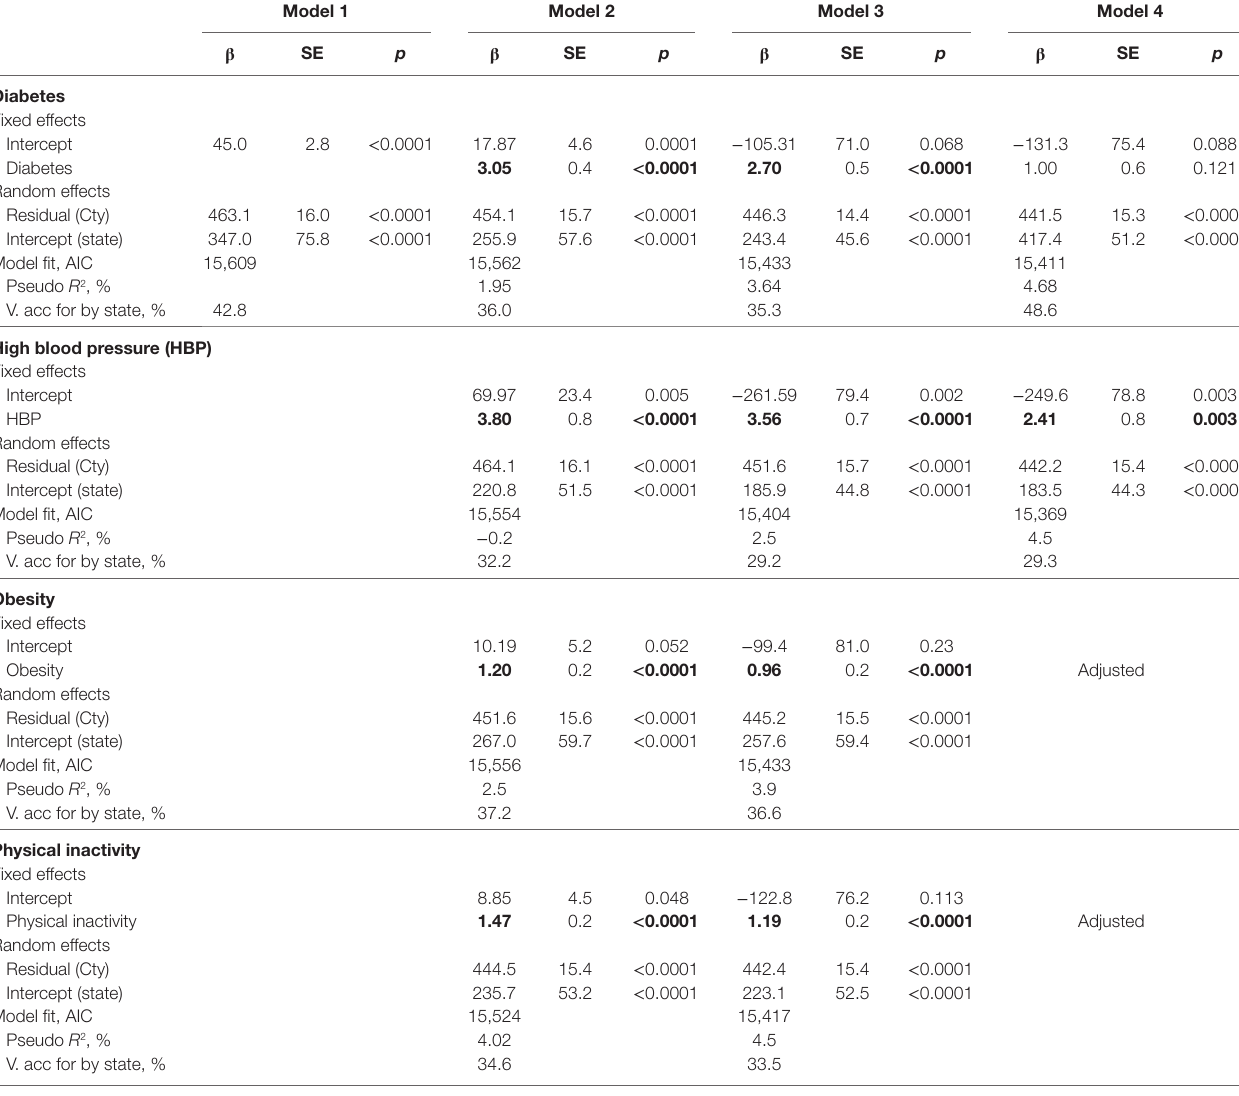
Model 1: test for variation accounted for by states. Model 2: test fixed effect of risk factor on HF mortality. Model 3: adjusted for male/female ratio, % of African American, and poverty rate in adults aged 18 and older. Model 4: adjusted for male/female ratio, % of African American, poverty rate in adults, % of obesity, and % of physical inactivity. AIC, Akaike information criterion; BIC, Bayesian information criterion. Pseudo R 2 represents the proportion reduction in residual variance between two nested